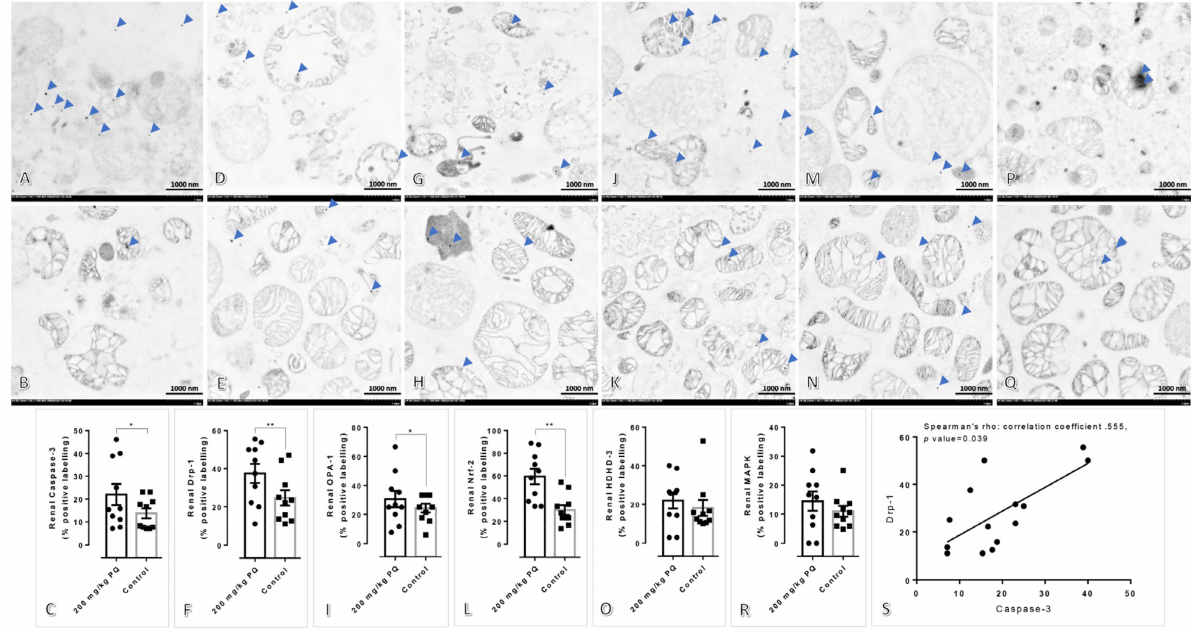
Figure 3. Immunogold labeling of caspase-3, Drp-1, OPA-1, Nrf-2, HDHD-3, and MAPK in renal mitochondria after treated with or without 200 mg/kg of PQ: ( A , D , G , J , M , P ) Renal mitochondrial architecture in rats treated with 200 mg/kg of PQ. ( B , E , H , K , N , O ) Renal mitochondrial architecture in non-treated rats. ( A – R ) Immunogold labeling of caspase-3, Drp-1, OPA-1, Nrf-2, HDHD-3, and MAPK in rats treated with or without 200 mg/kg of PQ, respectively. ( S ) Spearman’s correlation test between the levels of Drp-1 and caspase-3 in the renal mitochondria of rats treated with 200 mg/kg of PQ or not. The statistical significance of comparisons for subsequent figures is *; p < 0.05 and **; p <